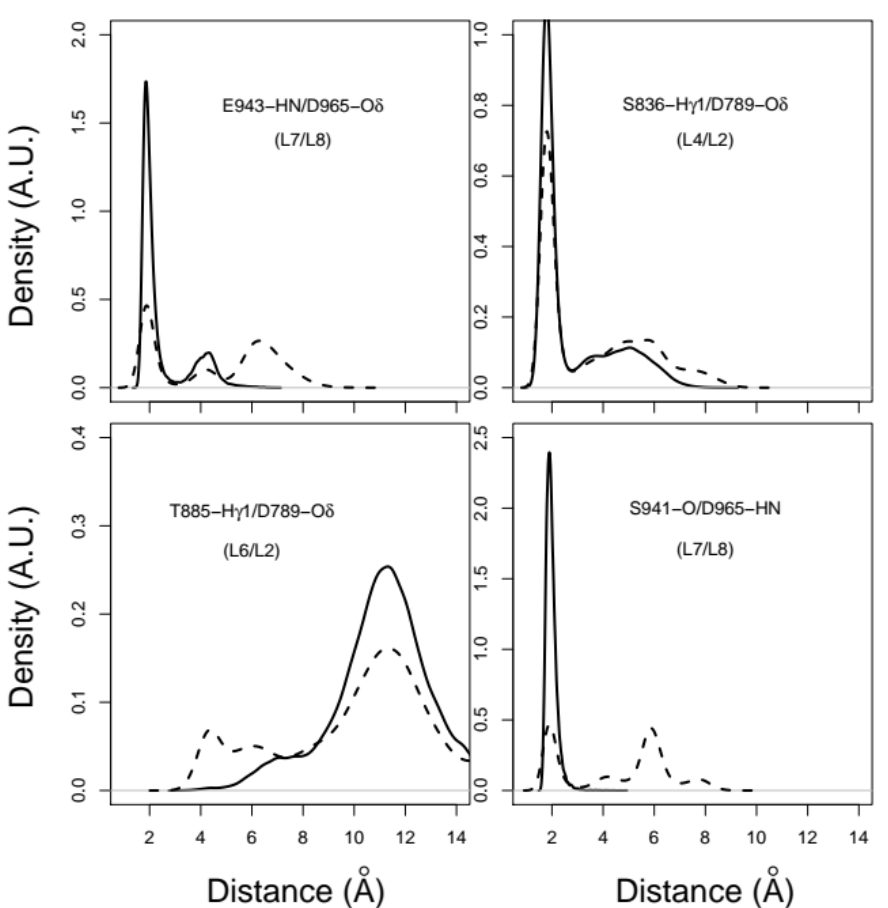
Figure 4. Interloop distance distribution between the following atoms: the HN atom from E943 (L7) and the O δ atoms of D965 (L8), the H γ atom from S836 (L4) and O δ atoms of D789 (L2), the H γ 1 atom from T885 (L6) and O δ atoms of D789 (L2), and O atom from S941 (L7) and the HN atom from D965 (L8). For distances involving atoms O δ 1/O δ 2, the minimum distance was conserved for each trajectory frame, and the atom was labeled O δ . The distributions are given for trajectories with cis conformations of the X-Pro imide bond (solid line) and for trajectories with trans conformations of X-Pro imide bonds (dashed line).